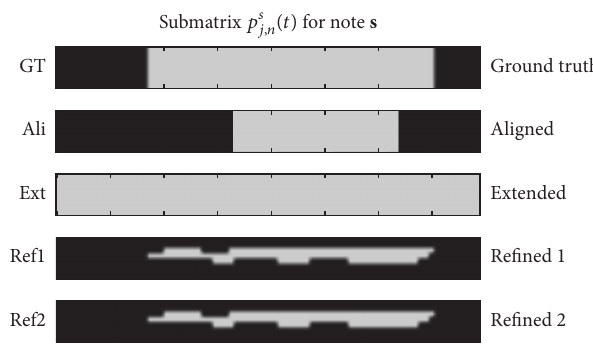
Figure 7: The test cases for initialization of score-informed source separation, for the submatrix 𝑝 𝑠 𝑗,𝑛 (𝑡)